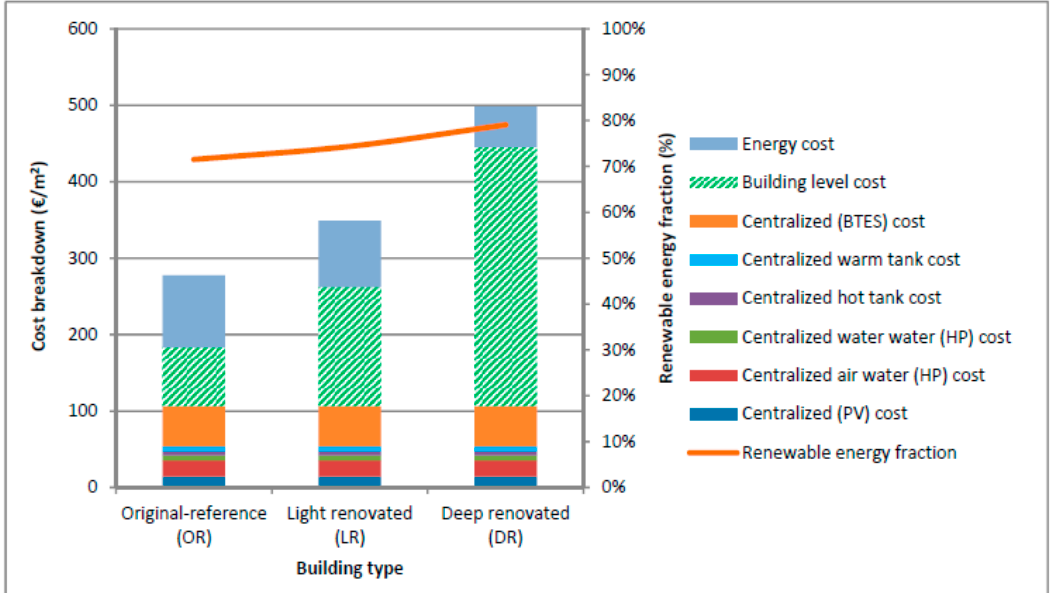
Figure 14. The breakdown of LCC of the old residential building community and centralized PV, HP and seasonal storage-based energy system (Case 3, PV + A2W + GSHP + STR).